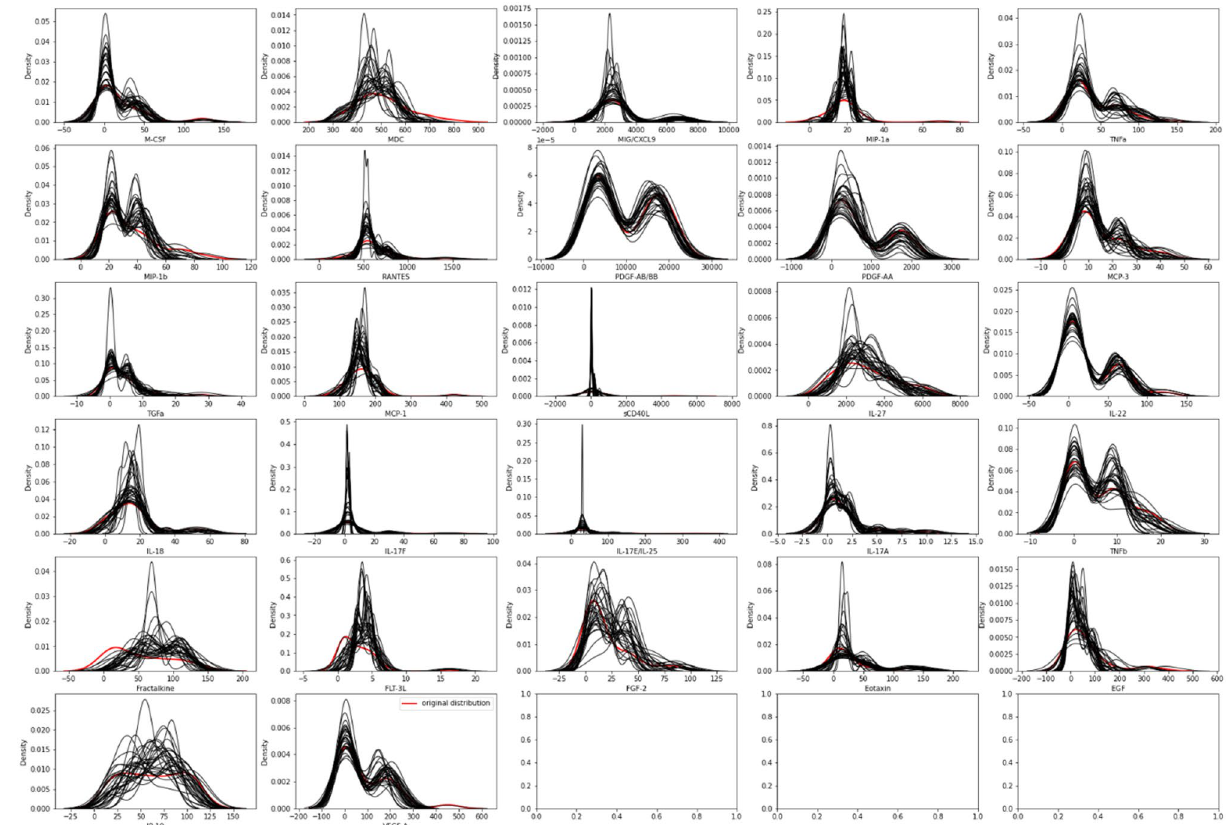
Figure 4. The distribution of each imputation compared to the original data (in